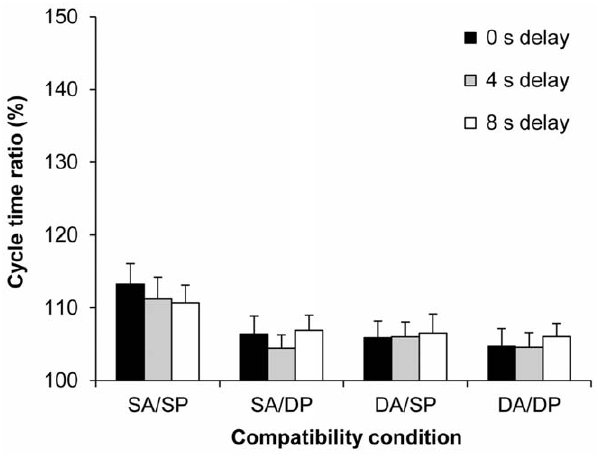
Figure 4. Automatic imitation experiment: Cycle time ratios (%). Mean cycle time ratios (with standard error of the mean) for the factors delay, action type compatibility, and plane compatibility (SA=Same Action; DA=Different Action; SP=Same Plane; DP=Differ- ent Plane). The cycle time ratio in the distractor actions was 150%.